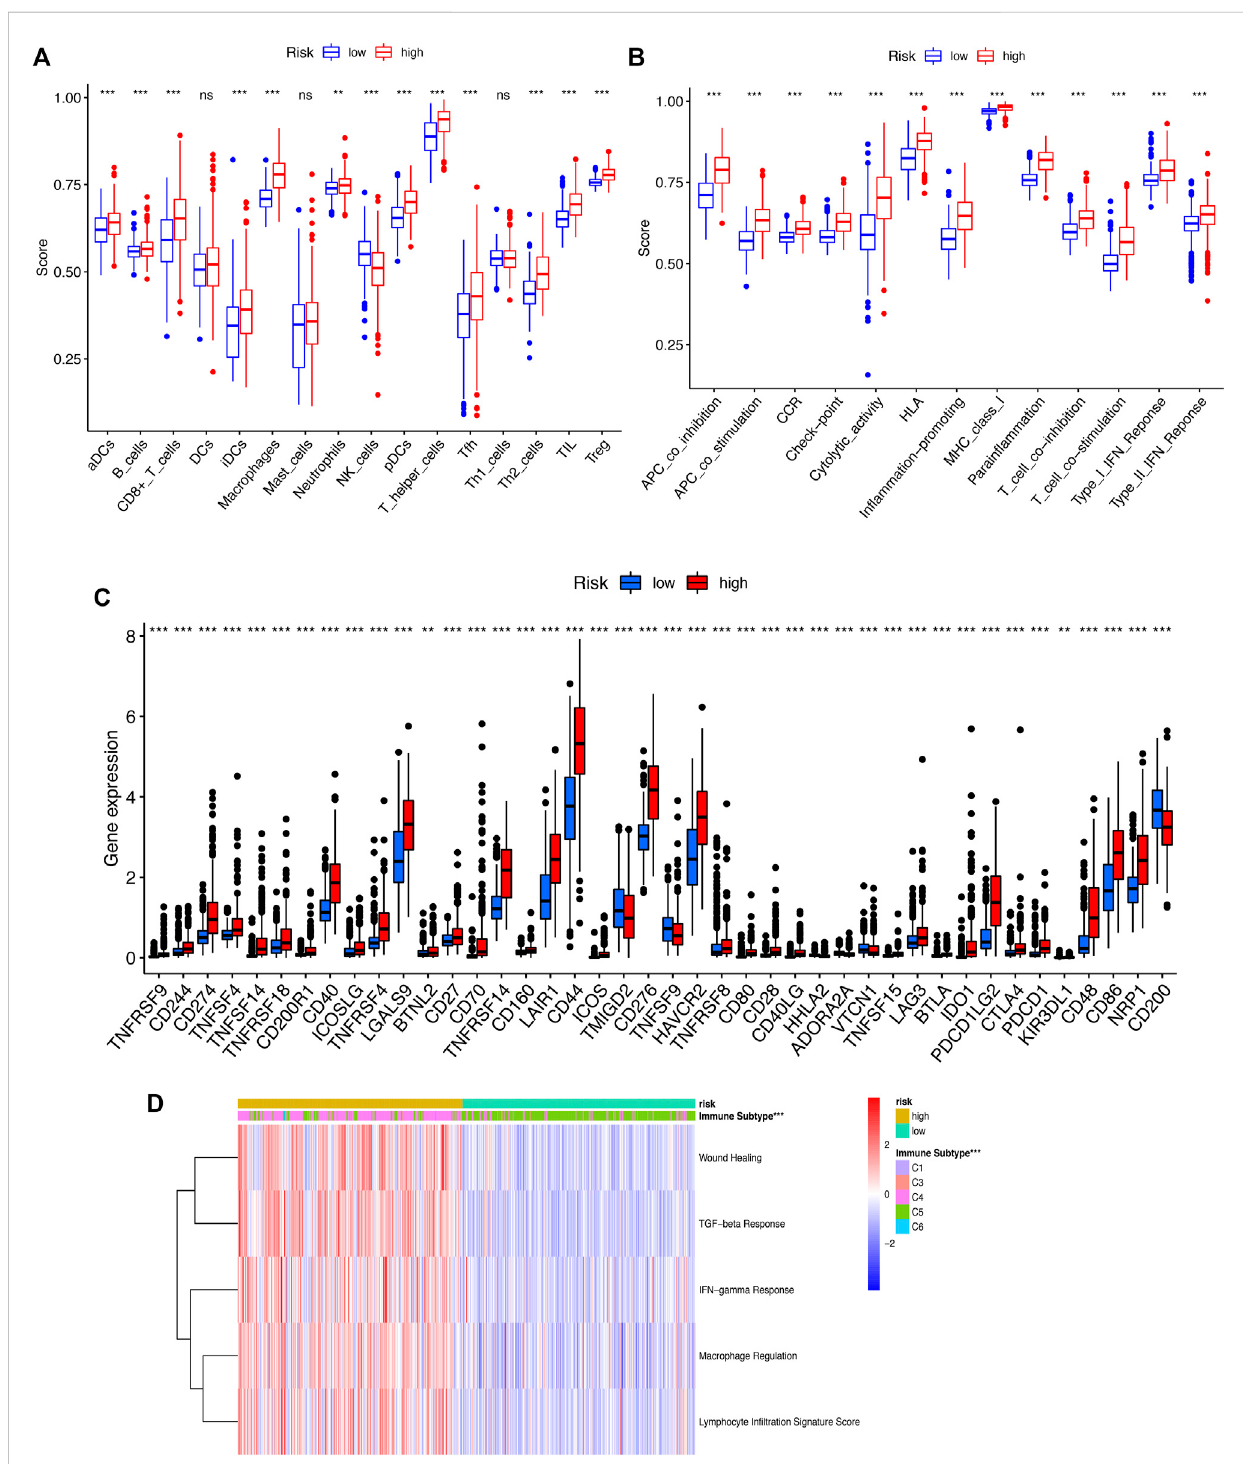
FIGURE 8 (A) ssGSEA algorithm was used to calculate the in fi ltration levels of 16 immune cells. (B) . The correlation between the predictive signature and 13 immun-related functions. (C) . The immune checkpoint. (D) . The immune subtype (C1-C6). ssGSEA, singlesample gene set enrichment analysis; * p < 0.05; ** p < 0.01; *** p < 0.001; ns, non-signi fi